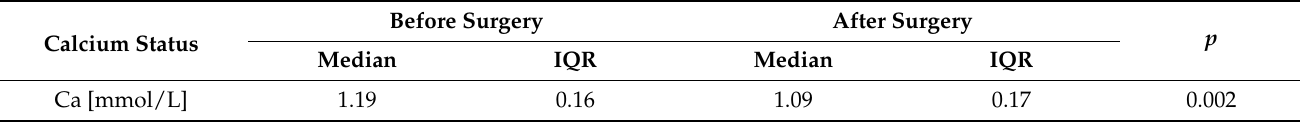
Table 3. Calcium status before and after